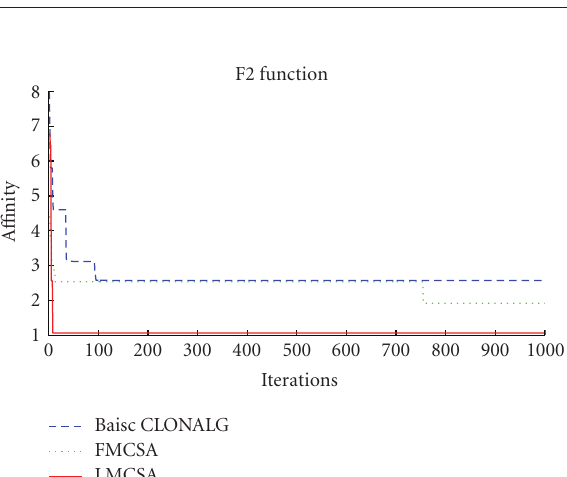
Figure 2: Schematic diagram of the ladder mutation factor concept. Worst AB represents the worst antibodies. Best AB represents the best antibody achieved so far. 0 represents an antibody.